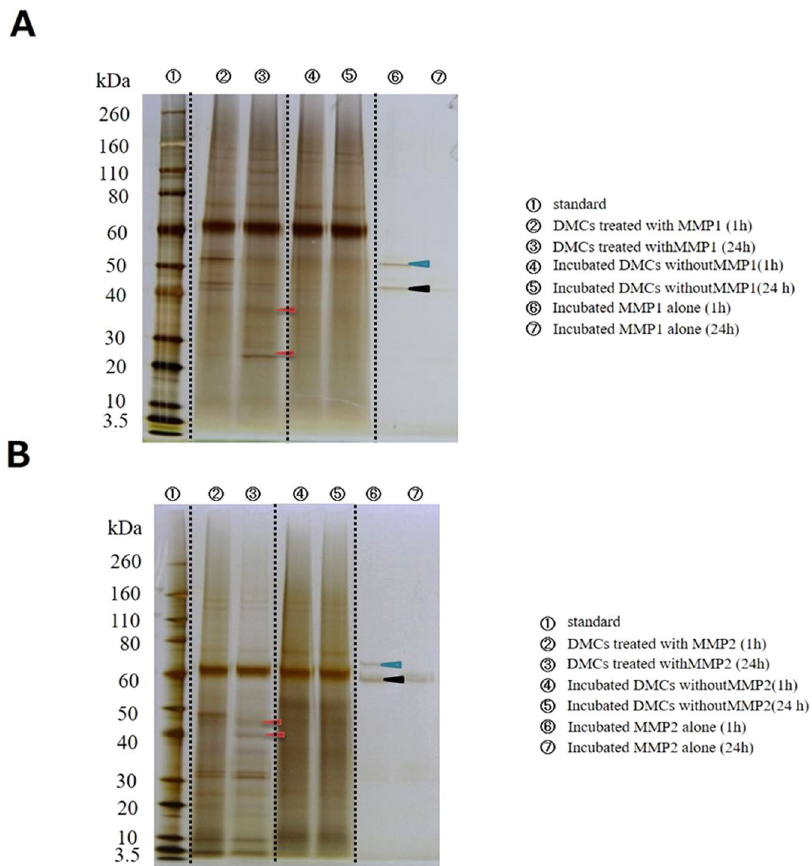
Figure 1. Protein profiles (silver staining) of dentin matrix components (DMCs) treated with matrix metalloproteinase (MMP)-1 ( A ) or MMP-2 ( B ) are shown as a merged view by combining images of the cropped blots and gels. Dotted lines indicate the borders of the cropped blots. The incubation time influenced the protein profile. Red arrowheads indicate the differences between protein profiles of MMP-treated DMCs following 1- and 24-h incubation. Light blue arrowhead indicates pro form of predicted MMP-1 and MMP-2, respectively. Black arrowhead indicates active form of predicted MMP-1 and MMP-2. Original full blots/gels are presented in Supplementary Fig.